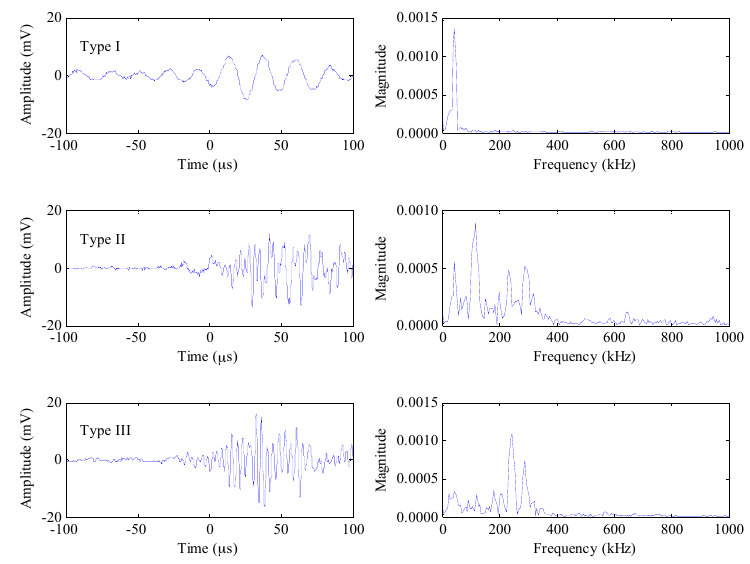
Figure 8. Typical waveforms of different types and their fast Fourier transform (FFT).